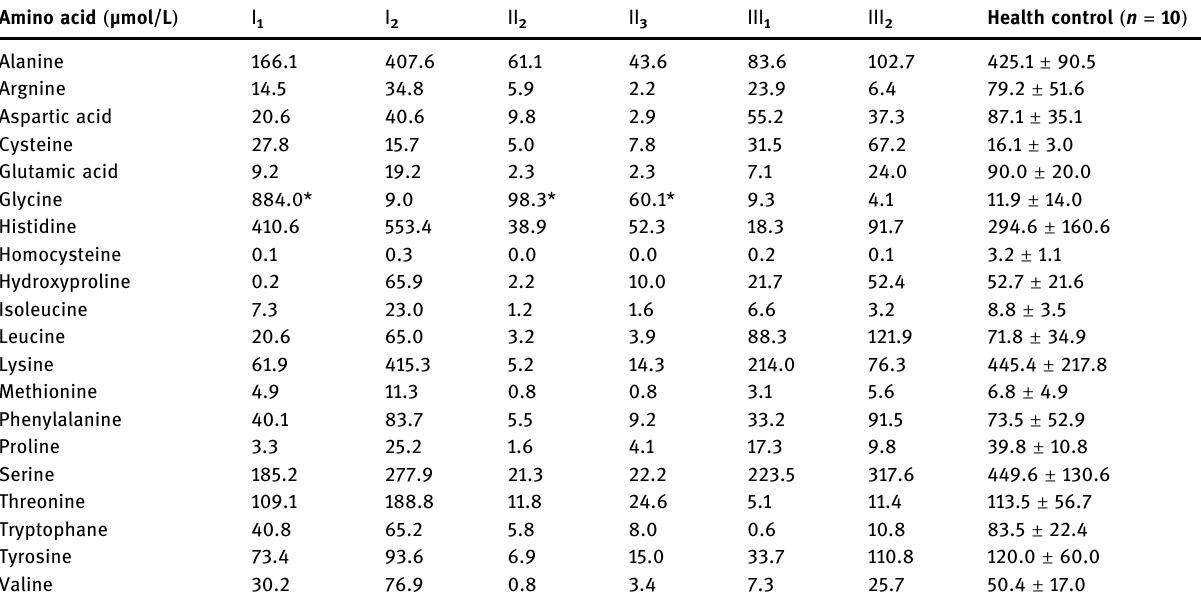
Table 2: The detection of 20 kinds of amino acids in urine Amino acid ( µmol/L )